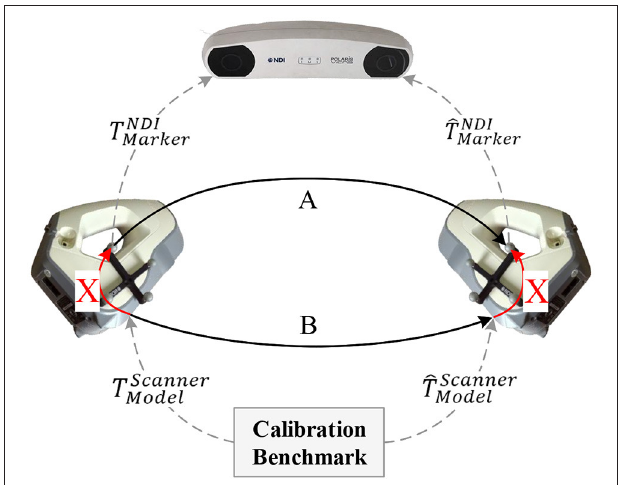
FIGURE 3 | Proposed calibration method for the 3D scanner.